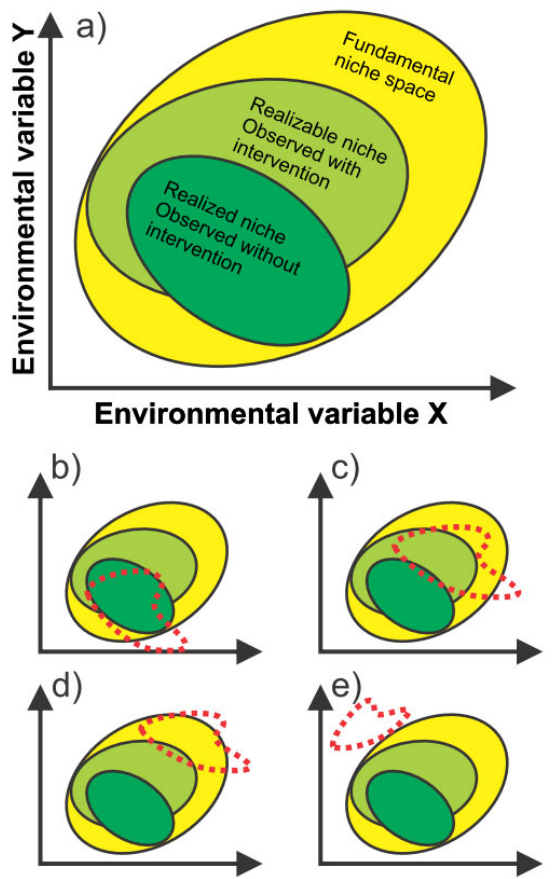
Fig. 1 . Hypothetical example of a niche space defined for two variables. The conditions that can support the species when growing alone define its fundamental niche space (yellow). The conditions that can support the species when growing in a community define the actual or realized niche (dark green). However, the extent of this range can be modified by interventions (i.e., modifications to the disturbance regime and related processes such as weeding) that modify the competitive environment to generate a different realized niche (light green); both realized niches cover different portions of the larger fundamental niche (a). Figures (b) to (e) conform to the labels in Figure (a) and illustrate different scenarios in terms of locally available habitat (range of environments bounded by the dotted line; for simplicity we assume that the actual physical area is evenly distributed across the environmental space within the bounded areas). In (b), available habitat matches well to the species’ needs and the intervention offers little benefit. In (c) the intervention improves the use of the available habitat. In (d), even though much of the habitat lies within the fundamental niche of the species, the intervention has only a marginal chance of maintaining the species, although it may nonetheless slow losses. In (e), neither prevailing conditions nor the intervention allow the species to persist although it may slow species loss; translocation is needed to an area with the properties within the red dotted